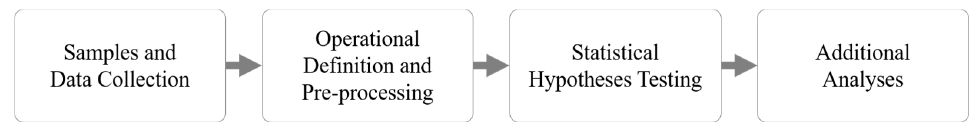
Figure 1. Research